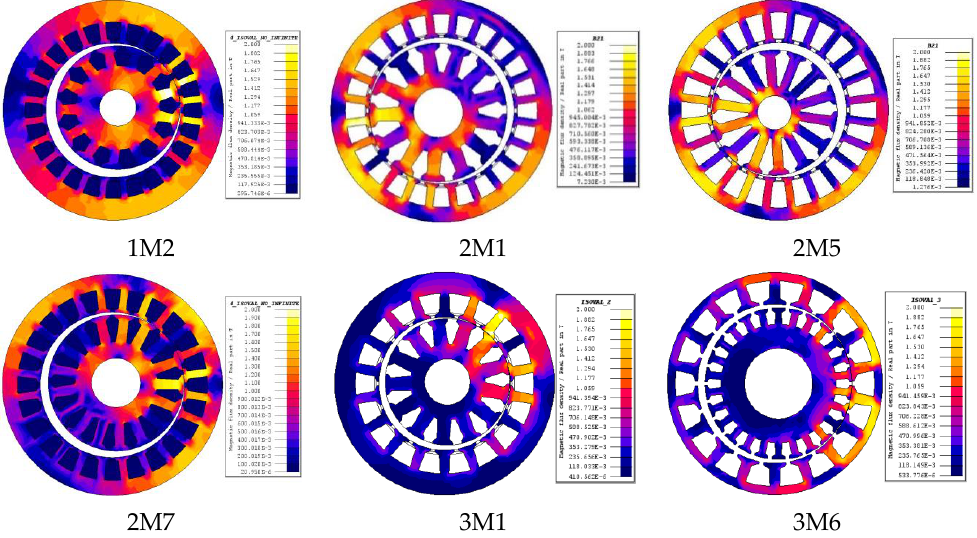
Figure 8. Flux density in the iron core of the ZAIMs with e = 1.5 mm.